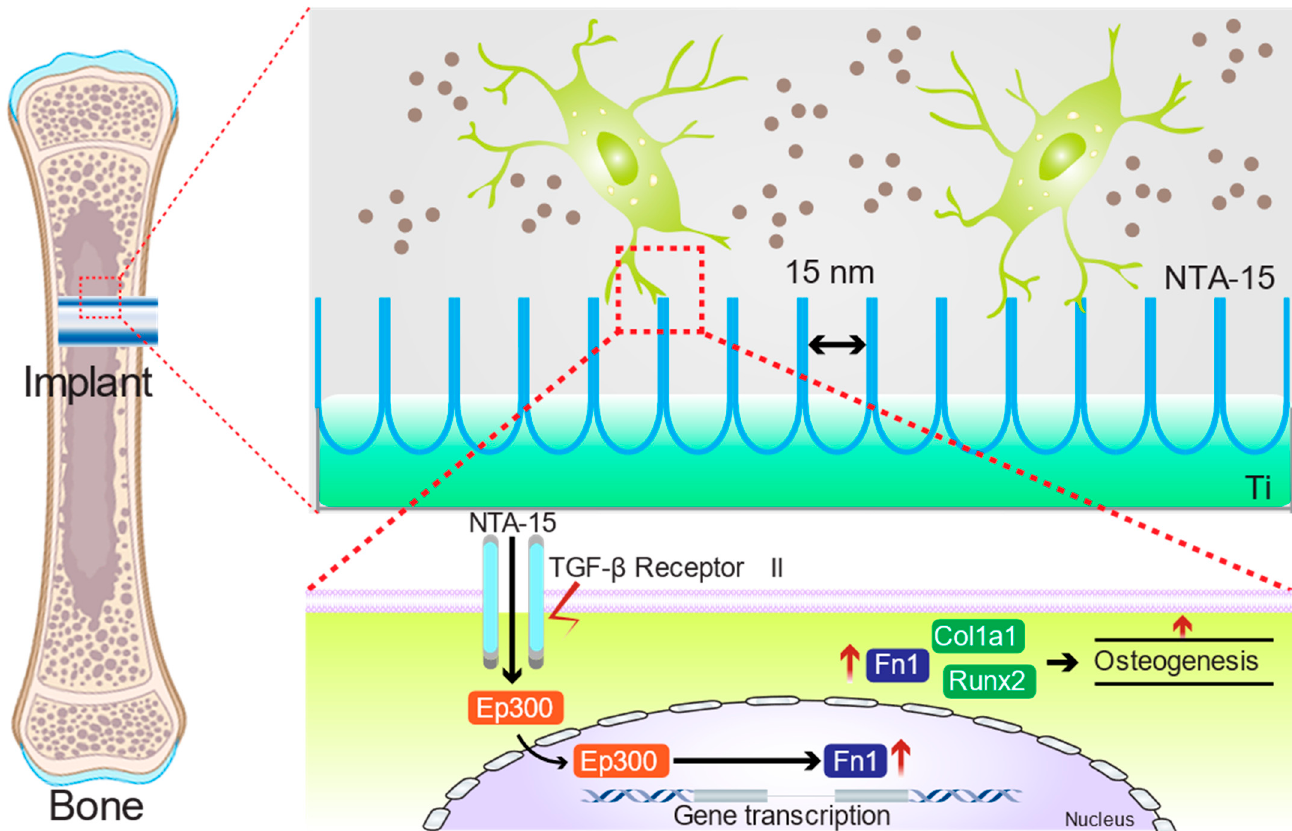
Figure 9. Schematic illustration of NTA-15-mediated TGF- β signaling pathway activation in the amelioration of osteogenesis.